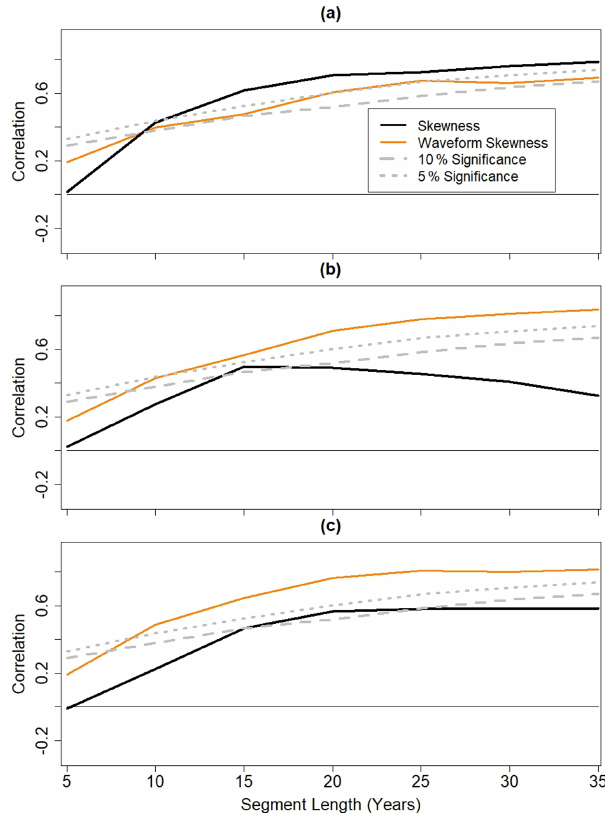
Figure 10. (a) Correlation between time series for Niño 1 + 2 skew- ness and waveform skewness and the sliding correlation time se- ries calculated between the Niño 1 + 2 index and AIR anomalies. (b) Correlation between time series for Niño 3 skewness and wave- form skewness and the sliding correlation time series calculated be- tween the Niño 3 index and AIR anomalies. (c) Correlation between time series for Niño 3 skewness and waveform skewness and the sliding correlation time series calculated between the Niño 1 + 2 in- dex and AIR